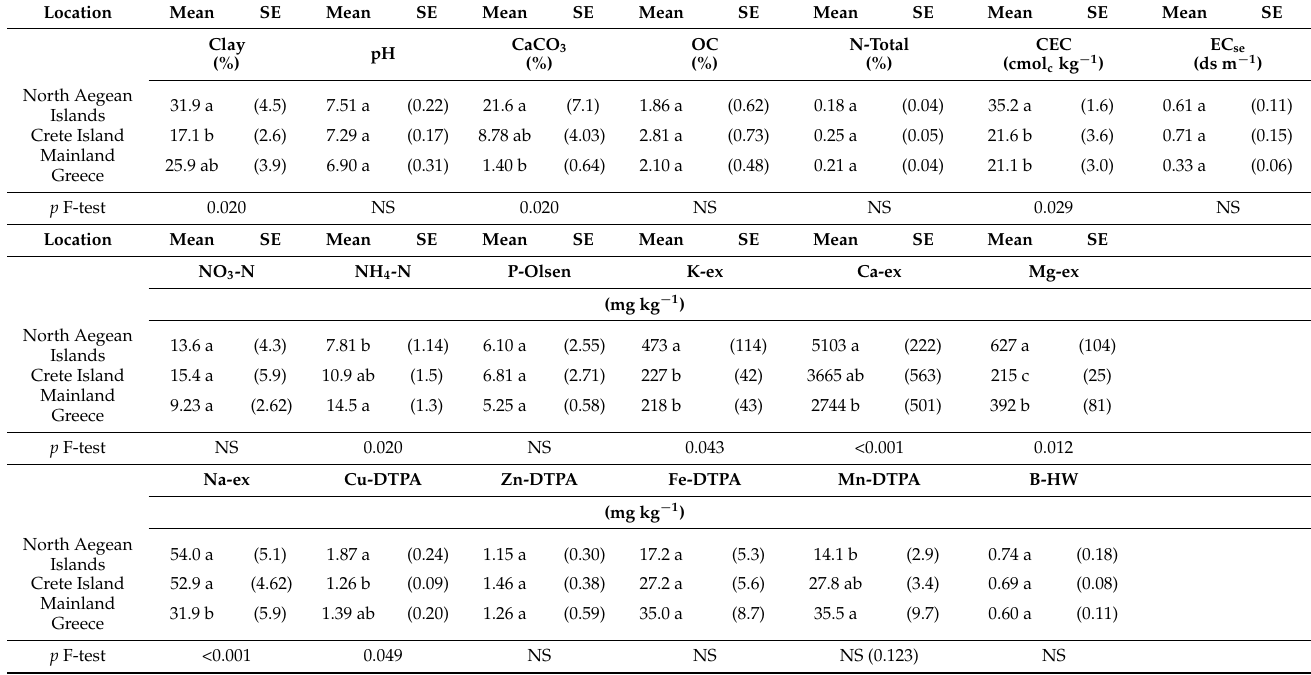
Table 7. Mean values of macro- and micro-nutrients’ soil available concentrations and respective soil properties of the sampled soil sites in terms of the specific phytogeographical unit (location) namely North Aegean Islands, Crete Island, and mainland Greece. SE: standard error; NS: non-significant. Within each soil available element, or soil property, different letters indicate significant differences among means, employing the protected LSD test, at p ≤